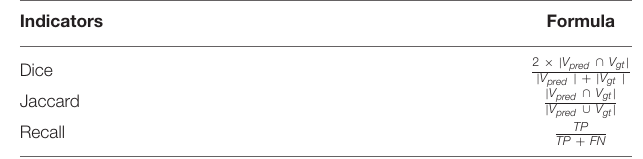
TABLE 2 | Parameter setting of EMDS-6 feature classification using SVM.